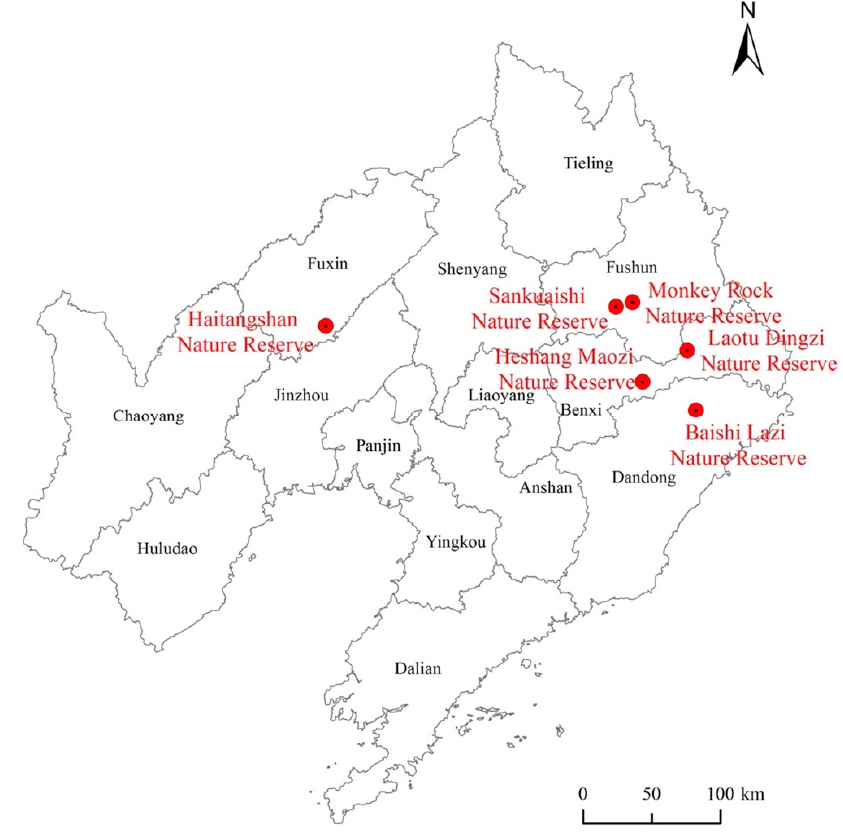
Figure 2. Illustration of the research area.